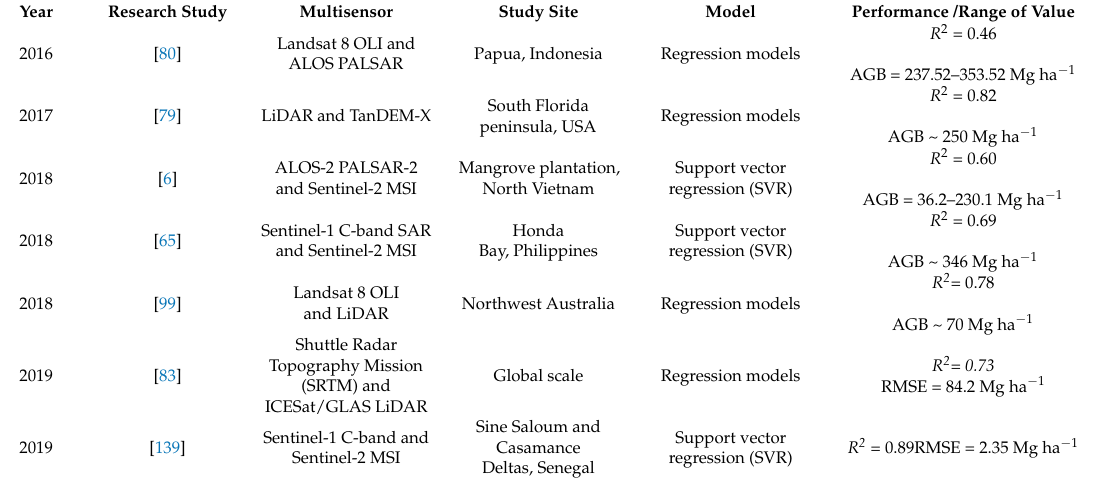
Table 5. Examples of multisensor data used for mangrove AGB